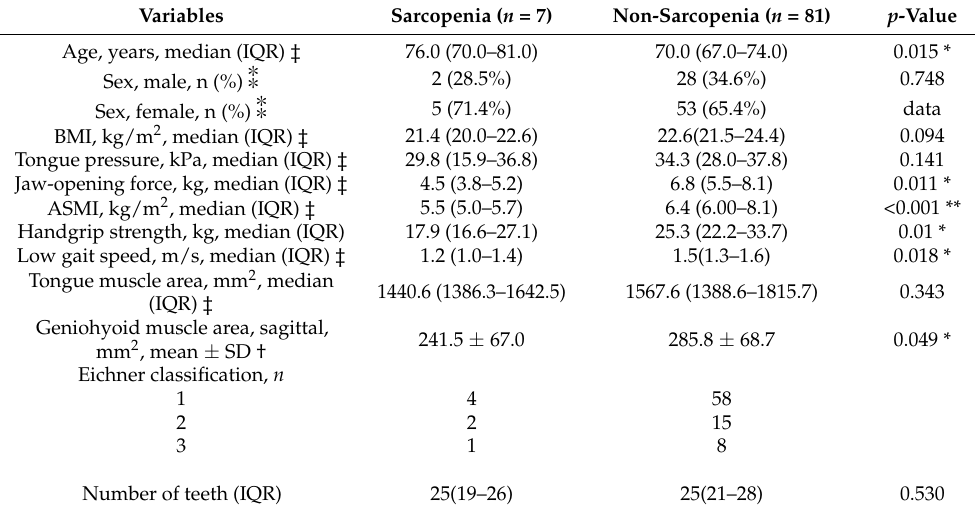
Table 3. Comparisons of characteristics between sarcopenia and non-sarcopenia groups.